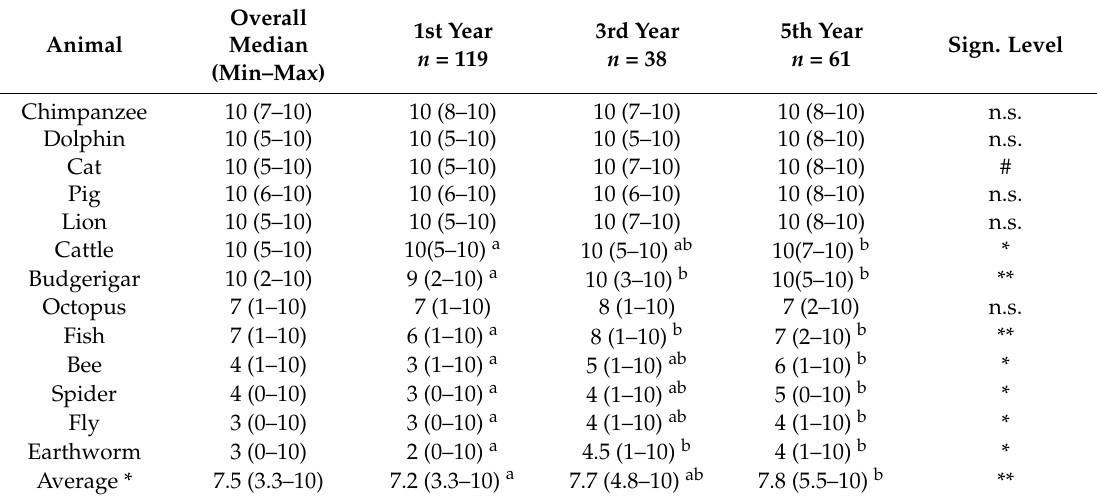
Table 3. Animal pain perception scores given by veterinary students ( n = 213), overall, and in study years 1, 3 and 5, based on a scale from 0: pain causes only reflexes–10: pain is subjectively experienced. Results are given as median (min-max). P-values indicate a difference between study years (n.s.